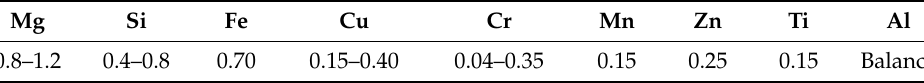
Figure 1. T-joint FE model.